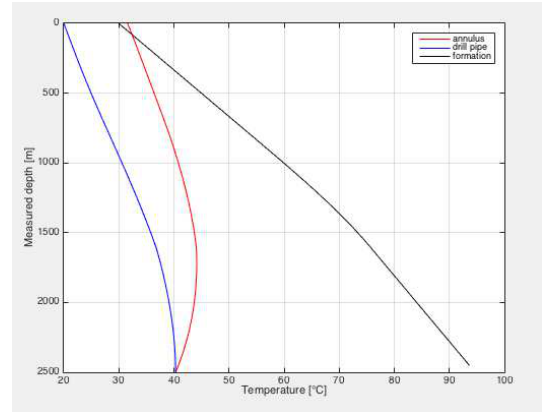
Figure 10: Temperature distribution( k f = 0 . 8 W/m ◦ C)